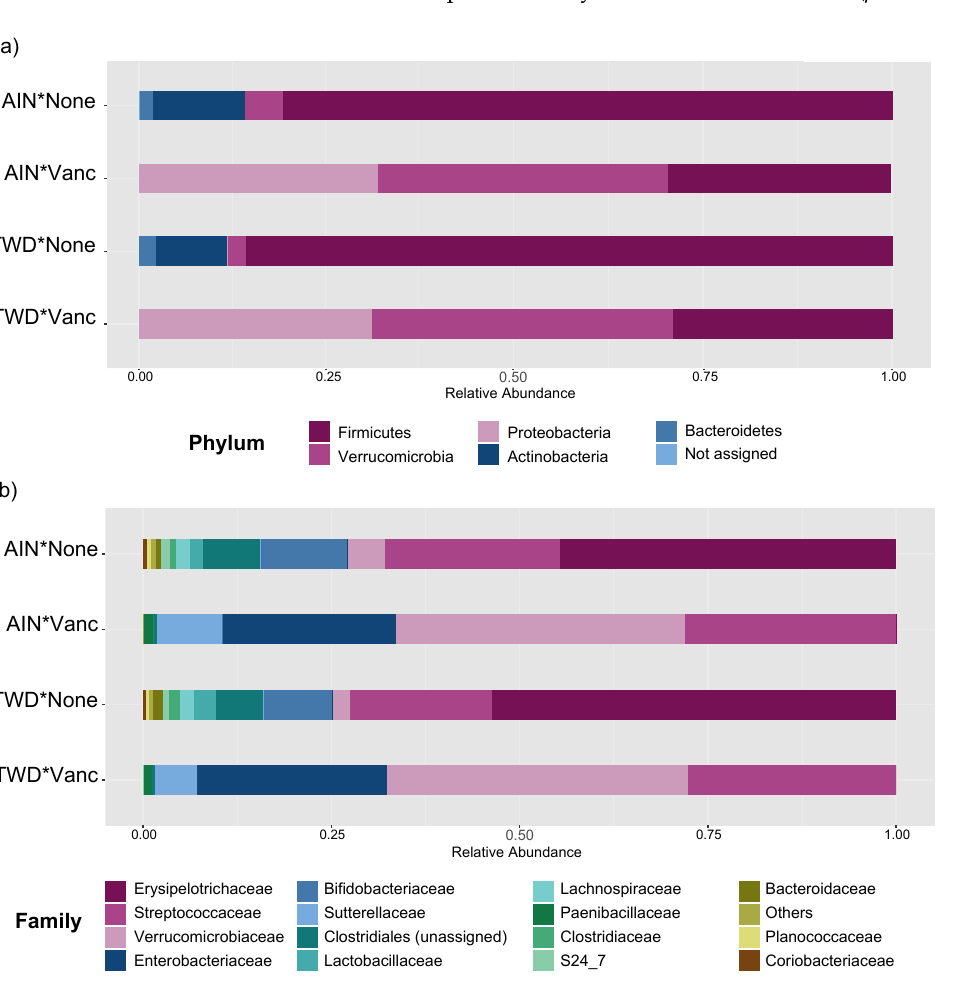
Figure 6. MetagenomeSeq of gut bacteria at the phylum, family, and genus taxonomic levels for main effects of diet or antibiotic and then pairwise tests for effect of antibiotic within each diet group or for diet within each antibiotic group. Values are the -log 10 FDR-adjusted p -values; blank cells were not significant. Statistical results with specific p -values are available in Table S2. Abbreviations: AIN, the AIN93G diet; TWD, the total Western diet; Vanc, vancomycin.